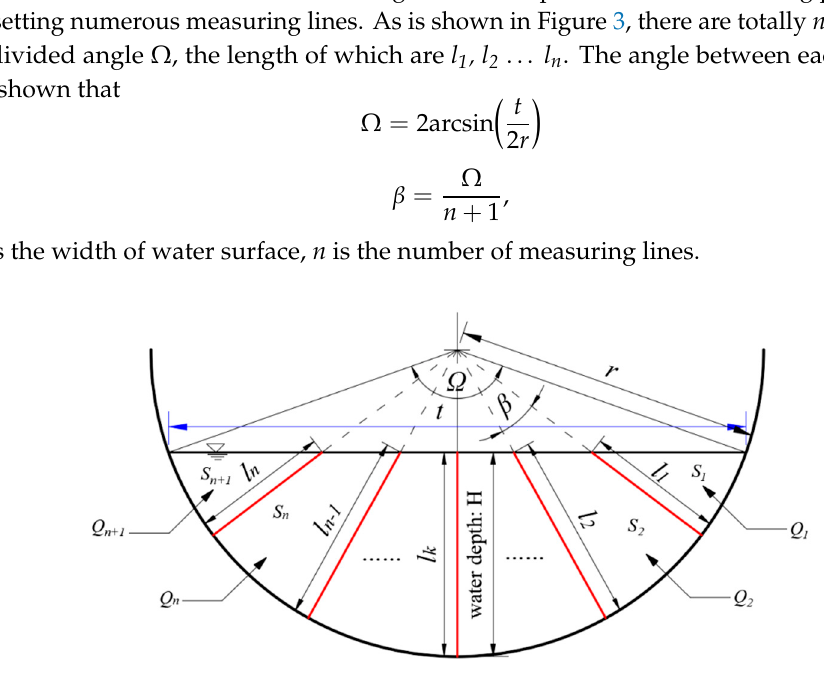
Figure 3. Diagram of estimating discharge with n -measuring-lines. Here, l 1 , l 2 ... l n are the lengths of measuring lines. S 1 , S 2 ... S n + 1 are sub-areas of cross-section. Q 1 , Q 2 ... Q n + 1 are discharges of sub-areas. Ω is the total angle. β is the angle between each two-measuring line. t is the width of water surface.